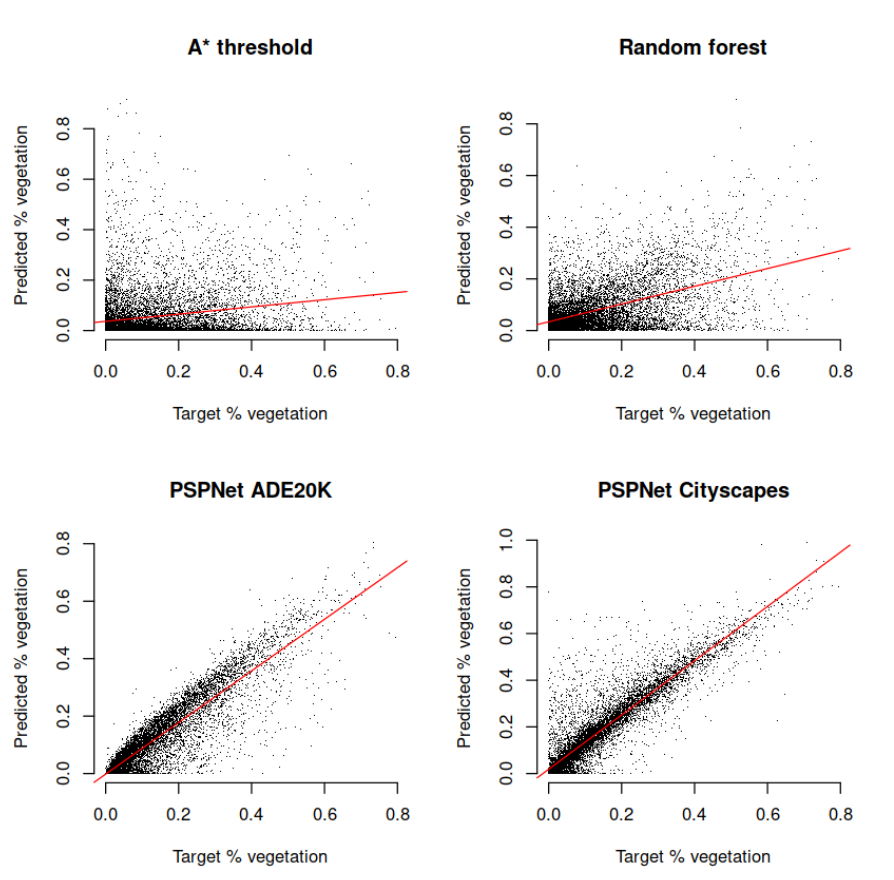
Figure 8. Comparison of actual levels of vegetation with predictions from different approaches. Horizontal axes display the actual percentage of vegetation; vertical axes contain predicted values by each approach. Best linear fit (bivariate correlation) is displayed as red